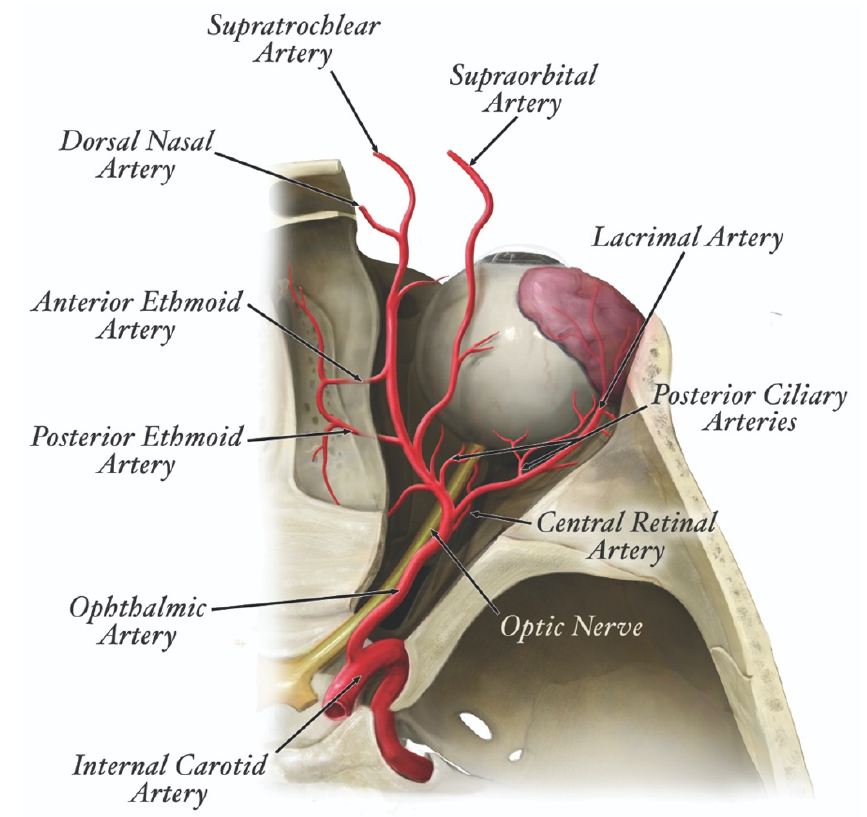
Figure 15. The vascular anatomy of the ophthalmic arterial system.